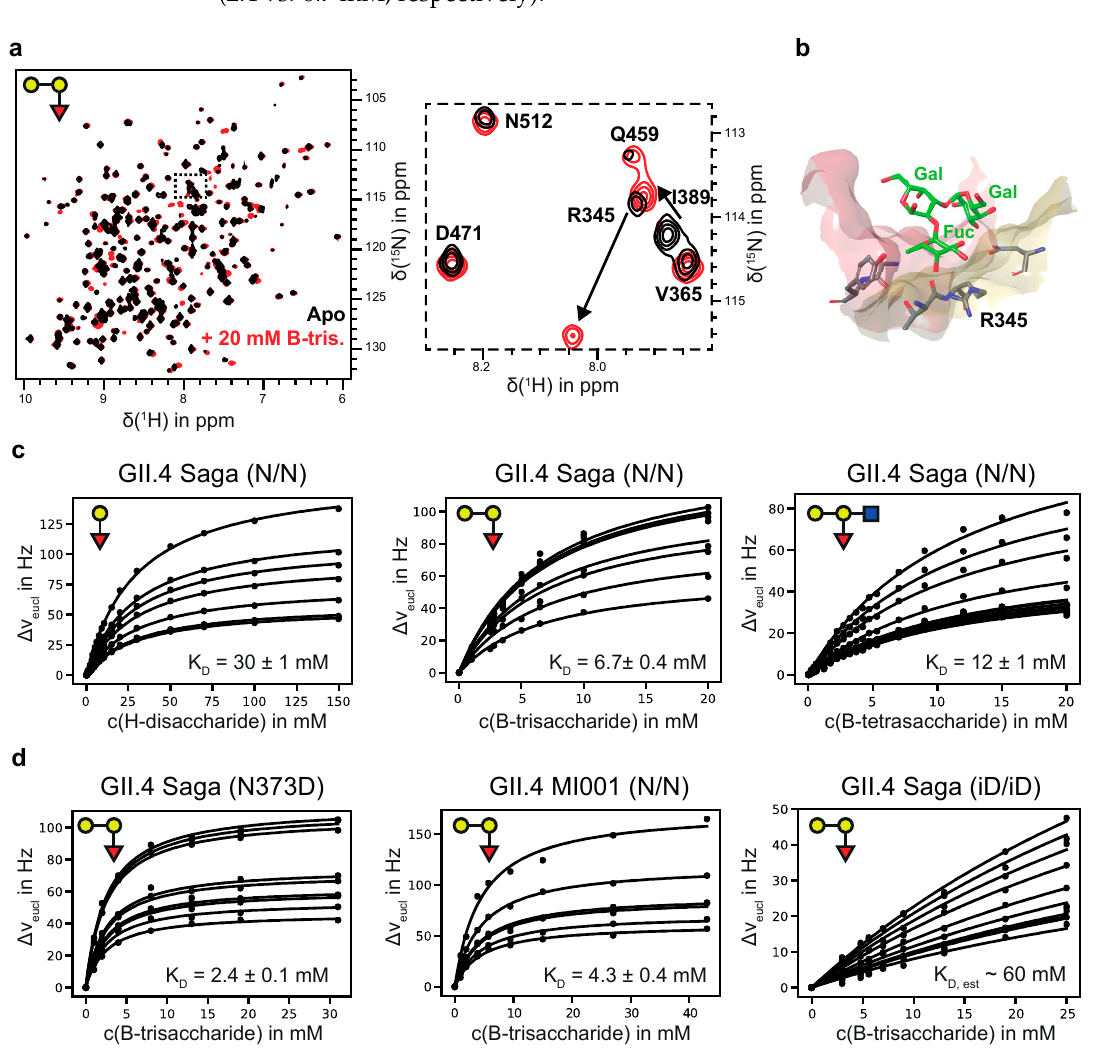
Figure 1. ( a ) 1 H, 15 N TROSY HSQC spectra of [ U - 2 H, 15 N]-labeled GII.4 Saga P-dimers in the absence and presence of B-trisaccharide 3 . The insert is highlighting CSPs due to binding of 3 . ( b ) HBGA binding pocket of GII.4 Saga P-dimers (pdb 4 × 06) highlighting the close proximity between the L-fucose residue and R345 causing the strong CSP shown in ( a ). ( c ) CSP titration curves for H-disaccharide 1 , B-trisaccharide 3 , and B-tetrasaccharide 4 (from left to right). ( d ) CSP titration curves for B-trisaccharide 3 binding to the N373D mutant of GII.4 Saga P-dimers, to MI001 P-dimers, and to fully deamidated GII.4 Saga P-dimers (from left to right).